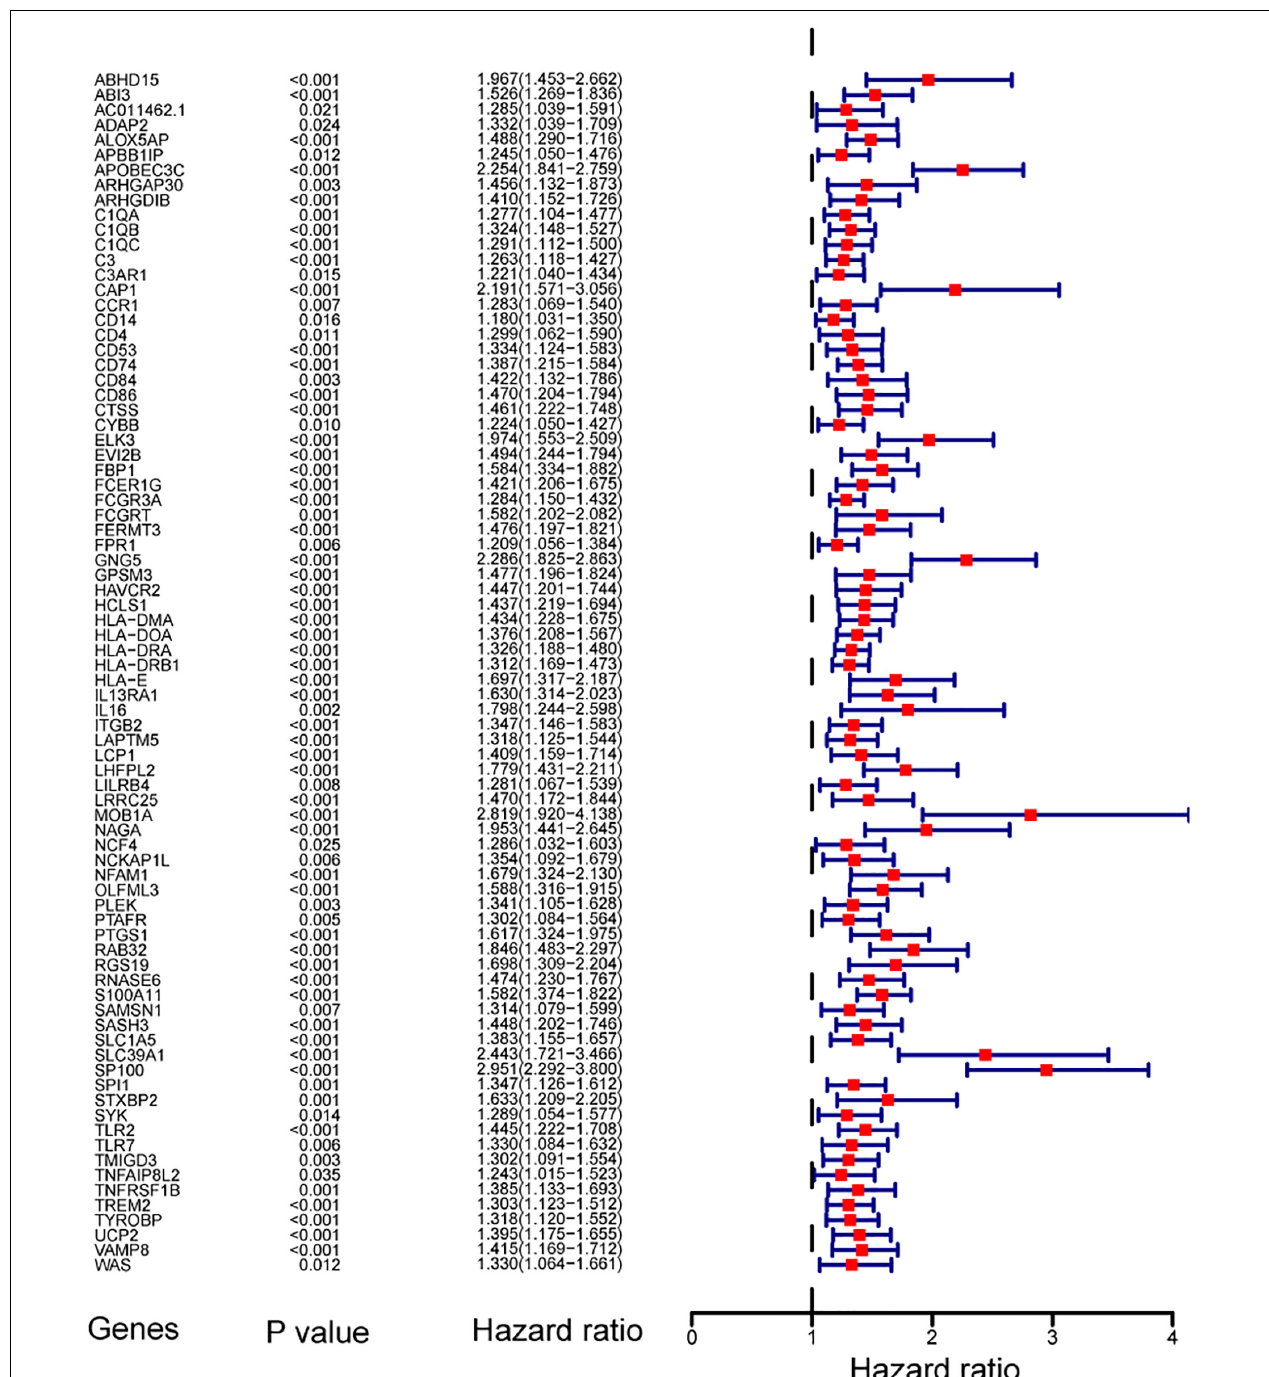
FIGURE 4 | Forest plot showing the hazard ratios from the univariate Cox regression analysis.